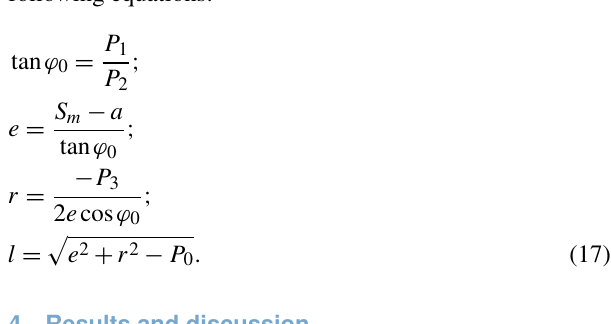
Figure 3. Kinematic scheme (a) and movement of the working slider (b) .